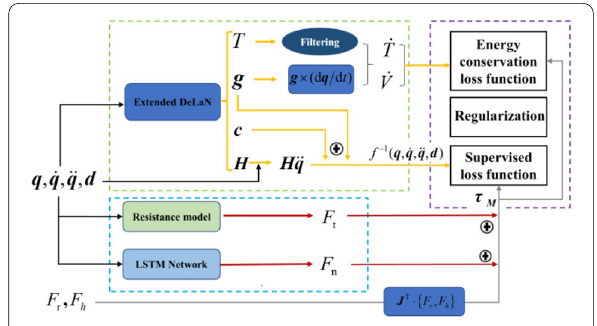
Figure 7 The proposed HPINN